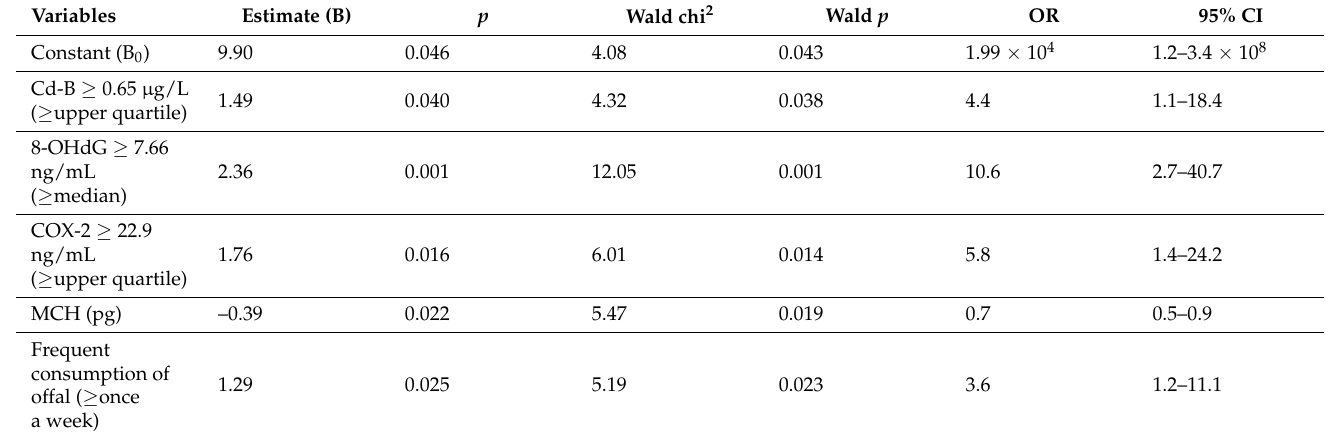
Table 6. Binary logistic regression model of selected inflammatory arthritis predictors in the study population (patients vs.